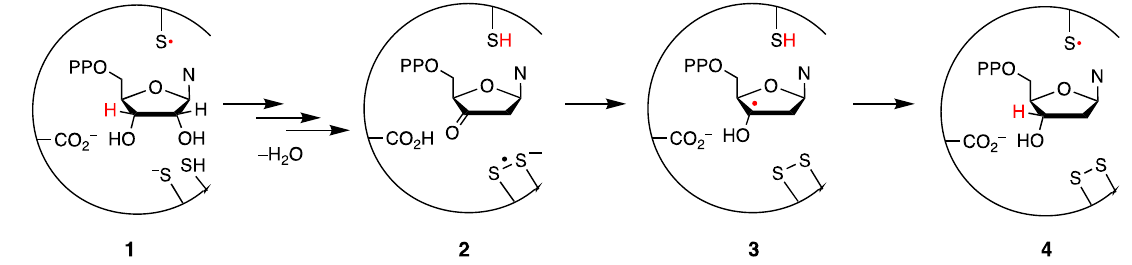
Figure 1. The transformation of ribonucleotides into 2 ′ -ribonucleotides by